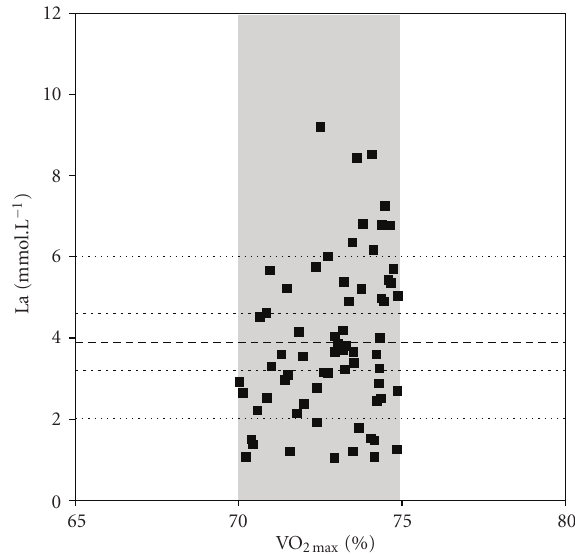
Figure 4: Mean blood lactate concentration (La) during constant load exercise in trained subjects applying controlled 70%–75% of VO 2max (unpublished